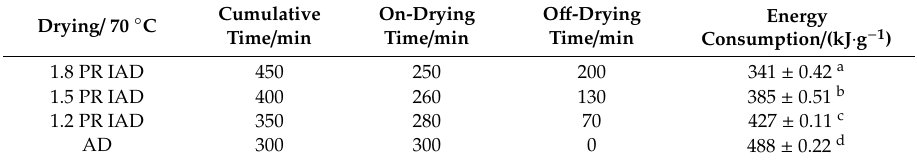
Table 1. Drying time and energy consumption of drying schemes of di ff erent pulse